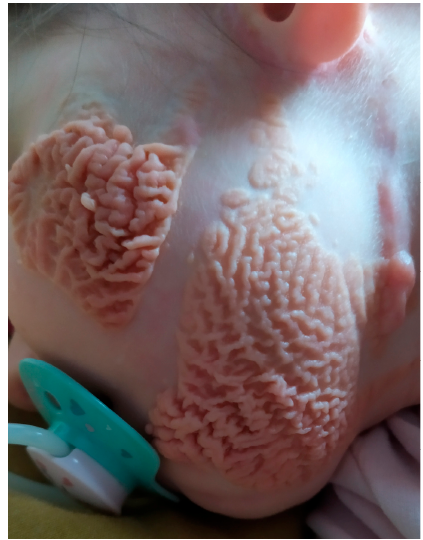
Figure 1. Skin lesion (nevus sebaceous) on the patient’s cheek and tumorectomy scar on the right. An initial ultrasound examination revealed an irregular, solid mass 21 × 24 mm in size with small contact with the superficial lobe of the left parotid gland, with a high level of vascularization and small calcifications. Laboratory tests did not indicate any elevation or significant alterations in markers such as beta subunit of human chorionic gonadotropin (beta-HCG), alpha-fetoprotein (AFP), or neuron-specific enolase (NSE). Magnetic resonance imaging (MRI) of the head and neck revealed a well-defined tumor mass located between the anterior pole of the parotid gland and the posterior part of the musculus masseter, 23 × 21 × 23 mm in size (Figure 2). The lesion seemed